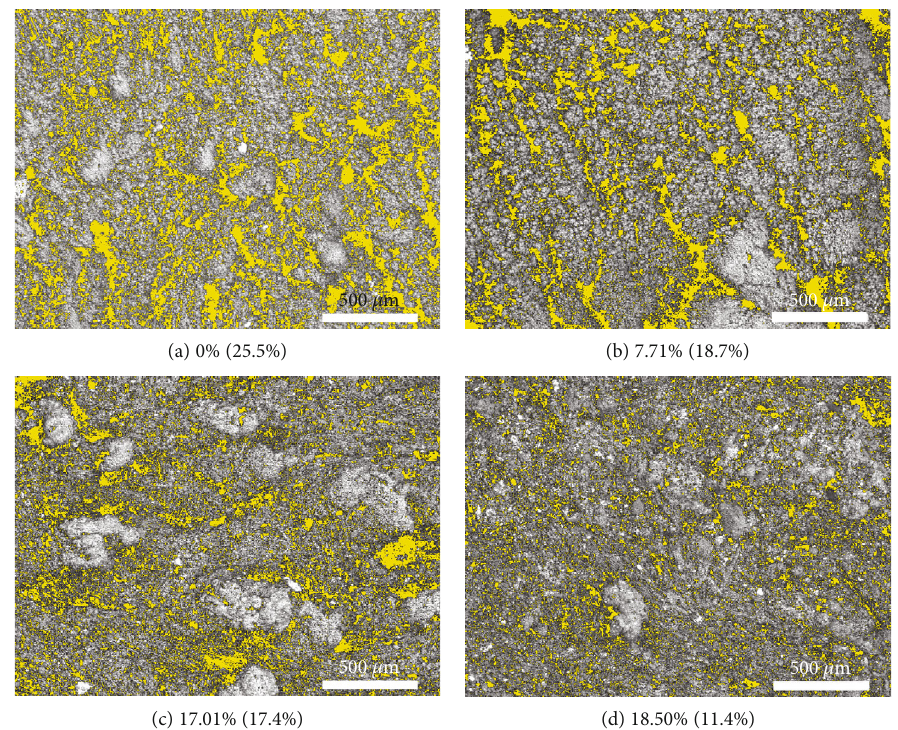
Figure 10: Porosity ratio image of the ceramic layer under di ff erent oxygen-rich